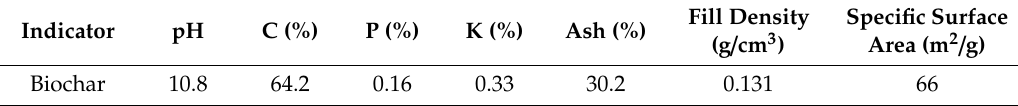
Table 1. Biochar physical and chemical indicators.